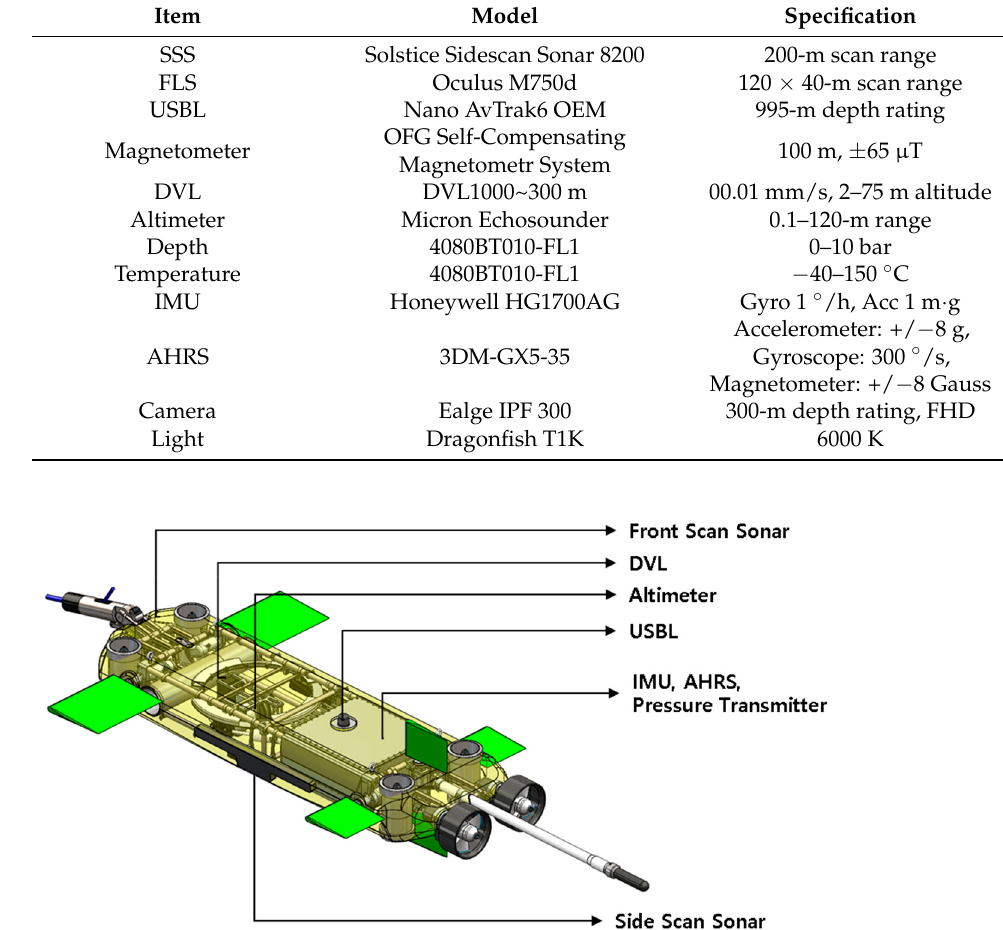
Figure 3. TUP sensor